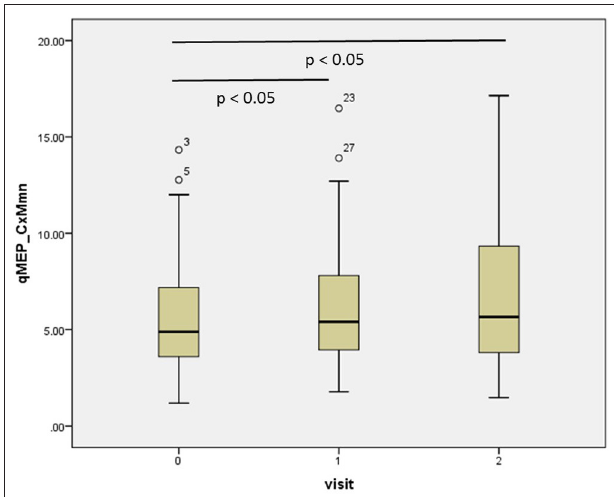
FIGURE 1 | Boxplot diagram showing the distribution of the combined quantitative MEP score based on the mean corticomuscular latency (qMEP_CxM-mn) at baseline, years 1 and 2. P -values are given for pairwise post-hoc comparison after Bonferroni correction.